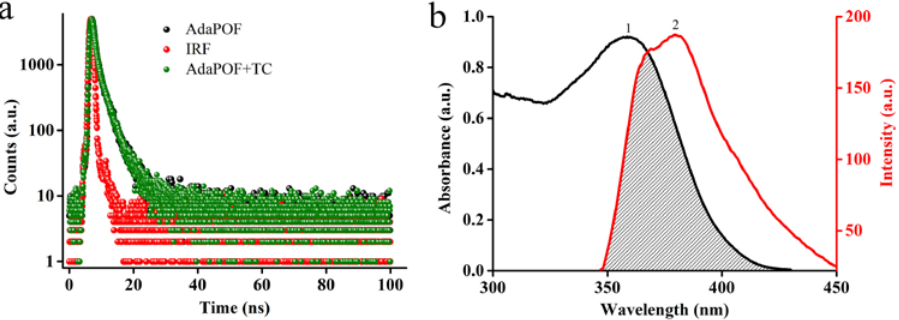
Figure 4. ( a ) The fluorescence lifetime of the AdaPOF suspension solution before and after TC– TC–methanol solution addition ( λ ex = 334 nm, c = 1.0 µ mol/L); ( b ) The UV–vis spectrum of TC